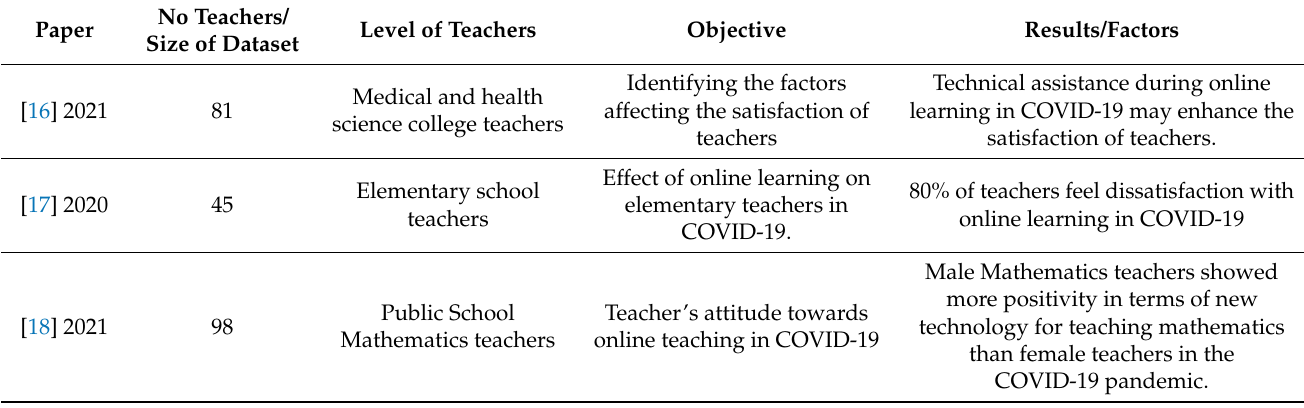
Table 1. Overview of Recent studies on the effect of COVID-19 on